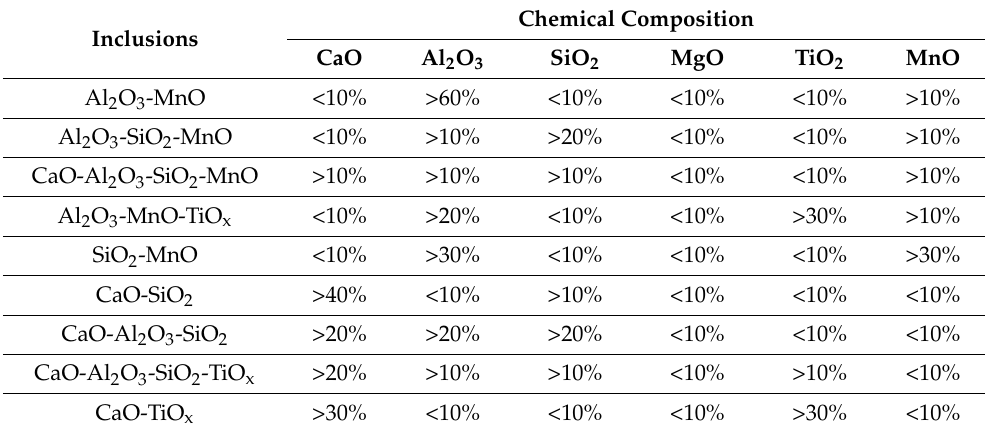
Table 2. Classification of inclusions based on the chemical compositions